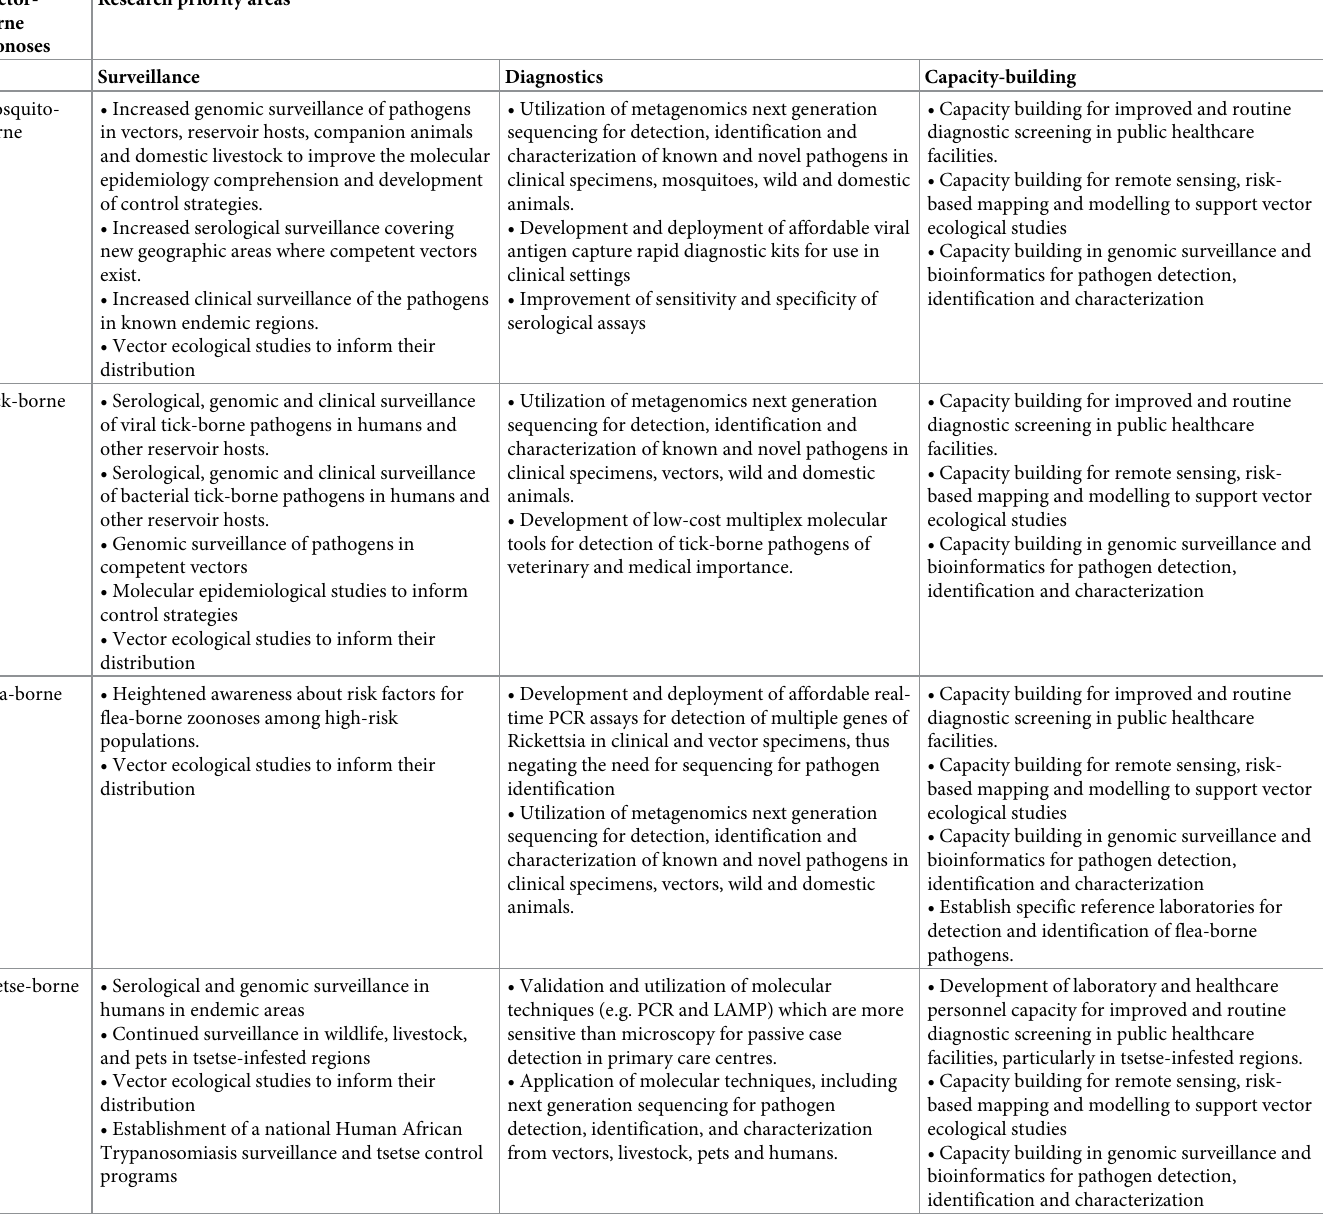
Table 2. Research priority areas for vector-borne zoonoses in Zambia requiring research